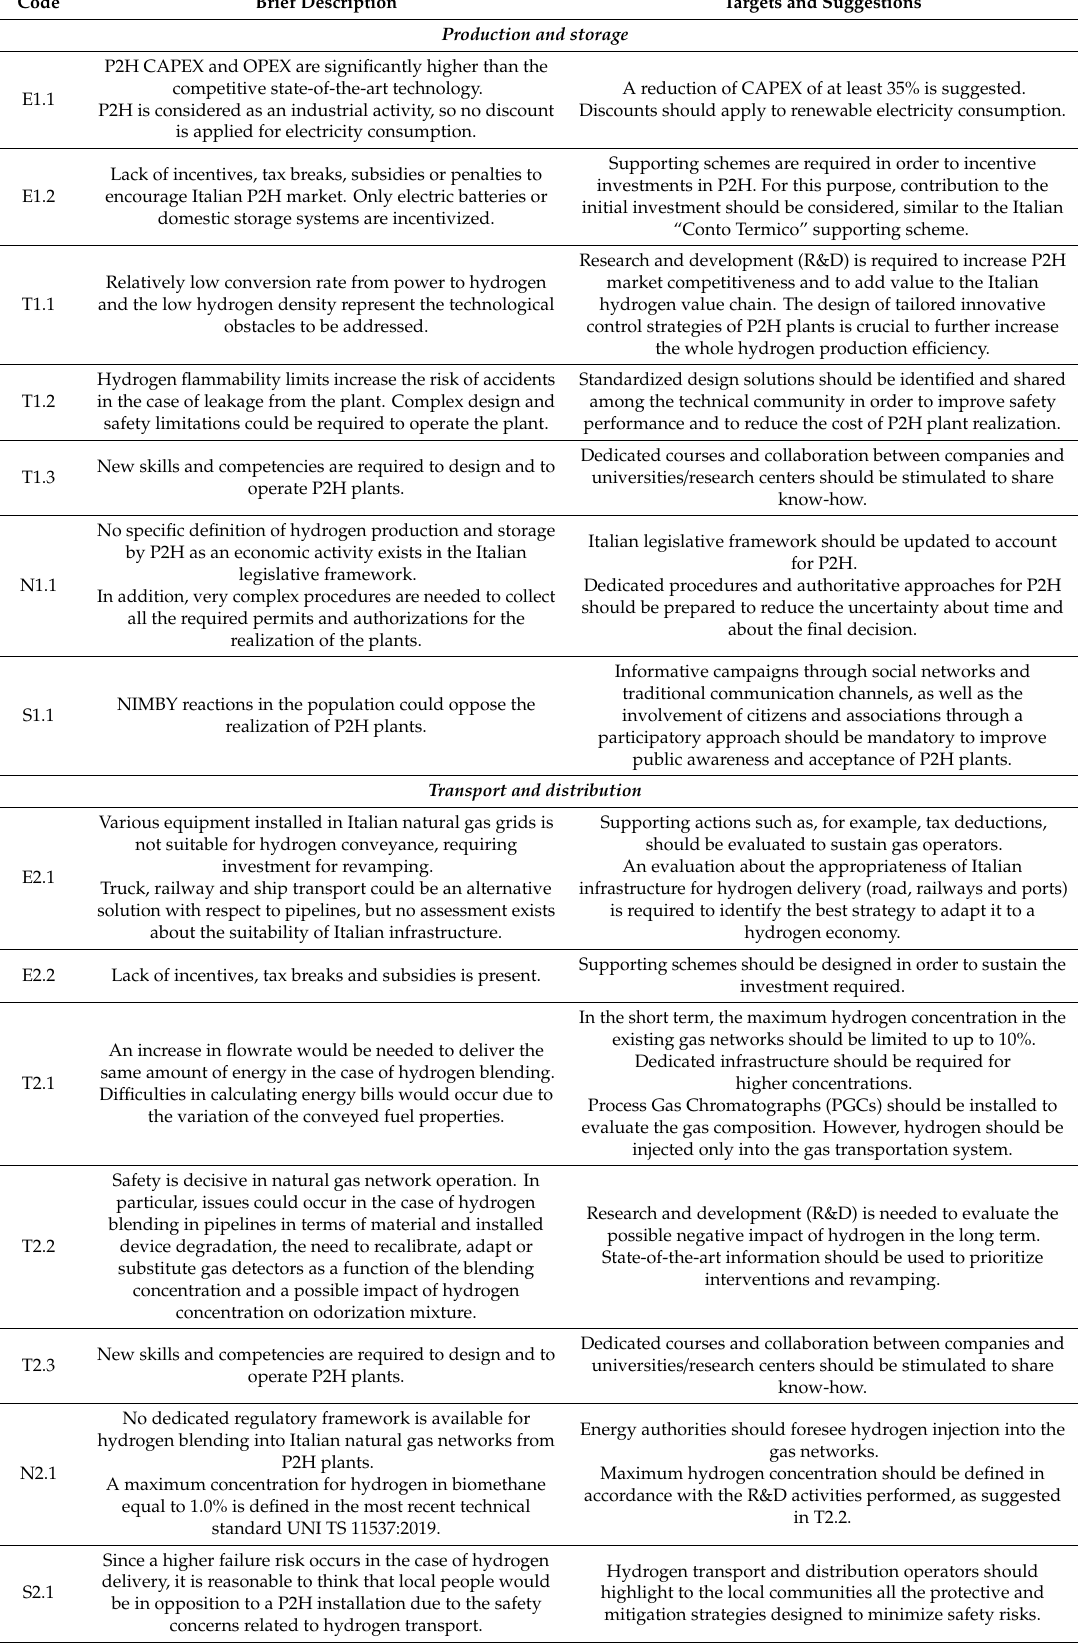
Table 6. Summary of existing barriers to Italian P2H implementation and possible targets /